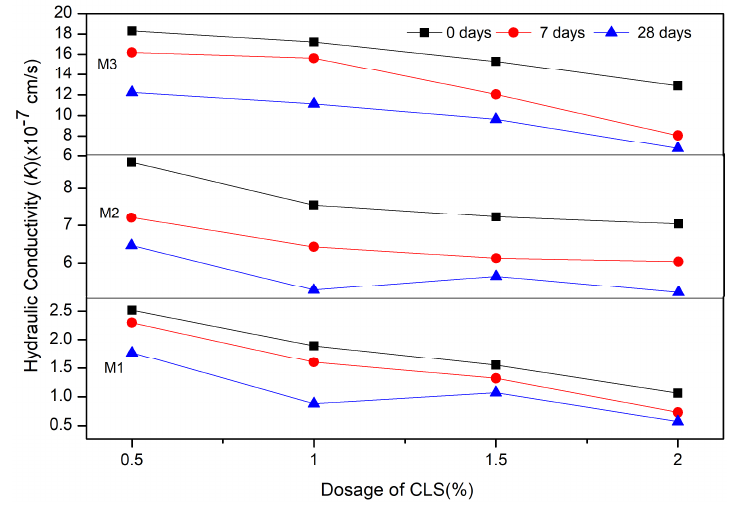
Figure 7. Variation in K with change in dosage of clay–GS–CLS mixes.